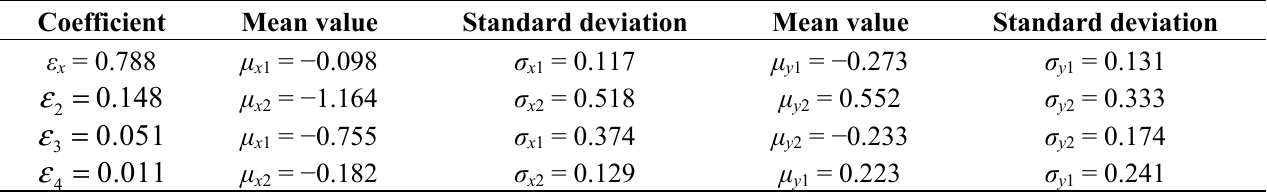
Table 7. The clustering results of the optimal phasor clustering